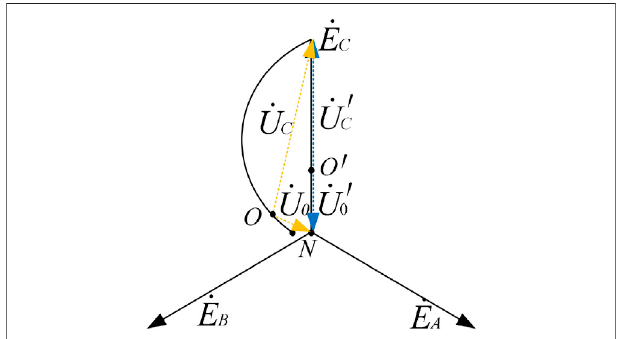
FIGURE 5 | Diagram of the system voltage variation before and after closure of the tap earthing branch.